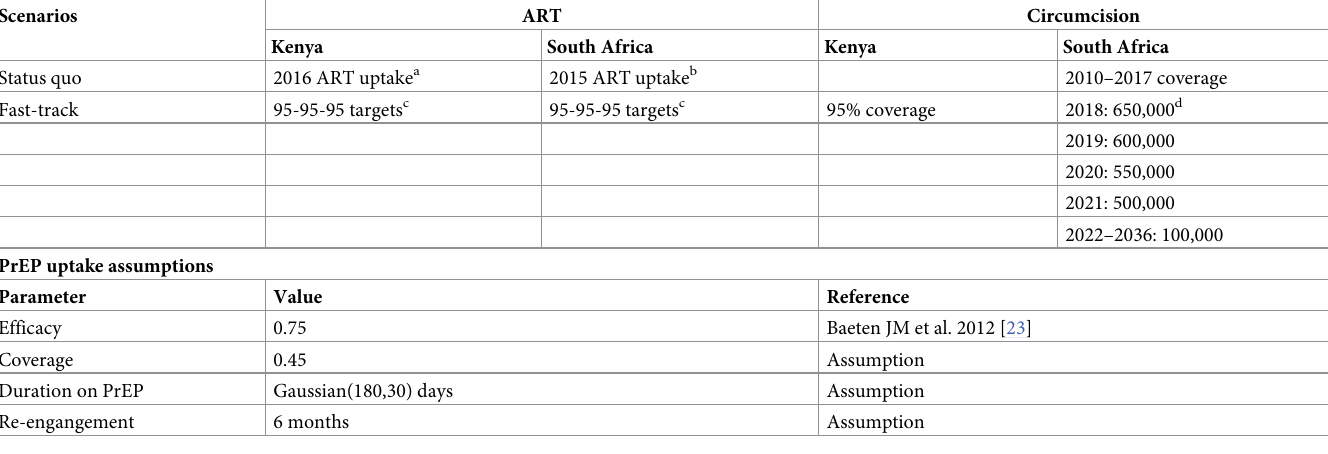
Table 1. Status quo and Fast track scenarios and PrEP uptake